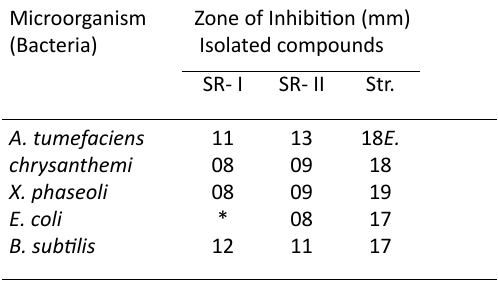
Table 1. Antibacterial screening of isolated compounds Microorganism Zone of Inhibition (mm) Isolated compounds